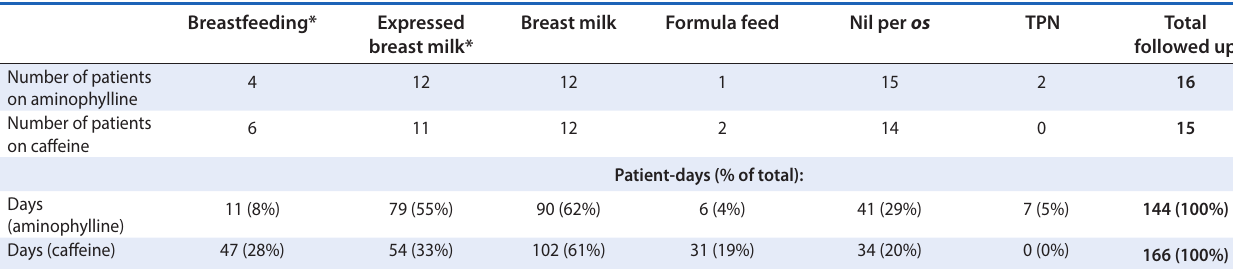
Table 3: Nutritional support given to the two study groups Breastfeeding* Expressed Breast milk Formula feed Nil per os breast milk*